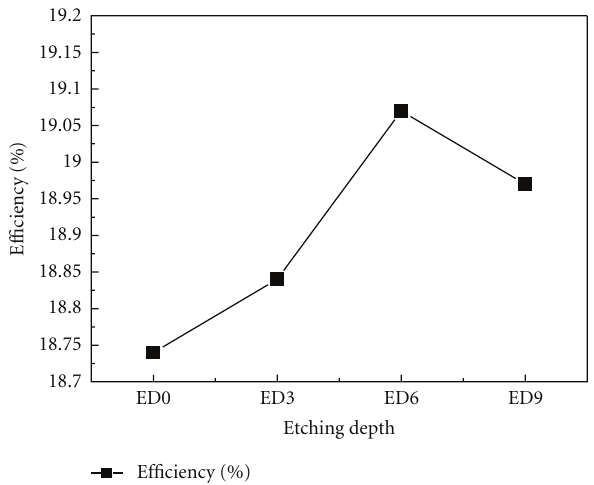
Figure 9: E ffi ciency of four di ff erent etching depths.